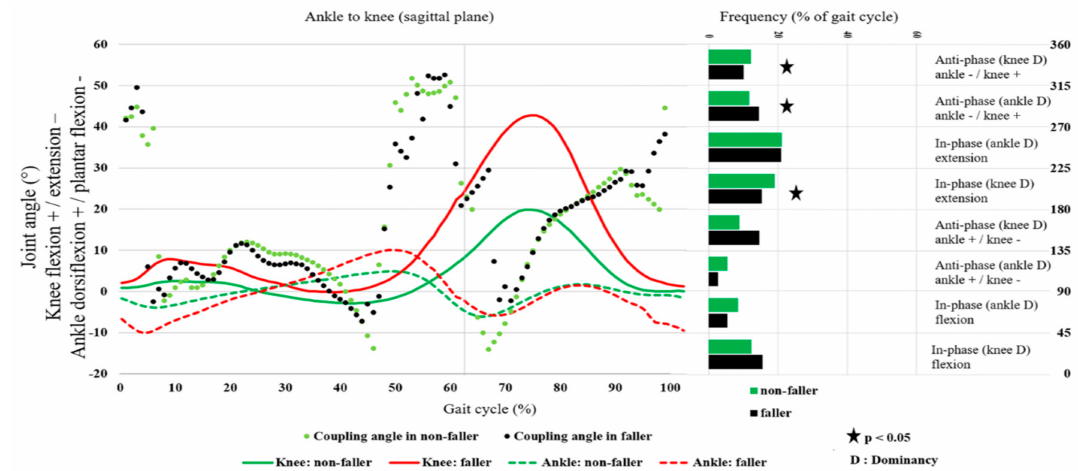
Figure 1. Ankle-to-knee angular displacement diagram (left axis), and frequency of coordination patterns (left axis) in the sagittal plane in fallers and non-fallers. The red and green solid lines are angular displacement of knee joint in fallers and non-fallers, respectively. The red and green dashed lines are angular displacement of ankle joint in fallers and